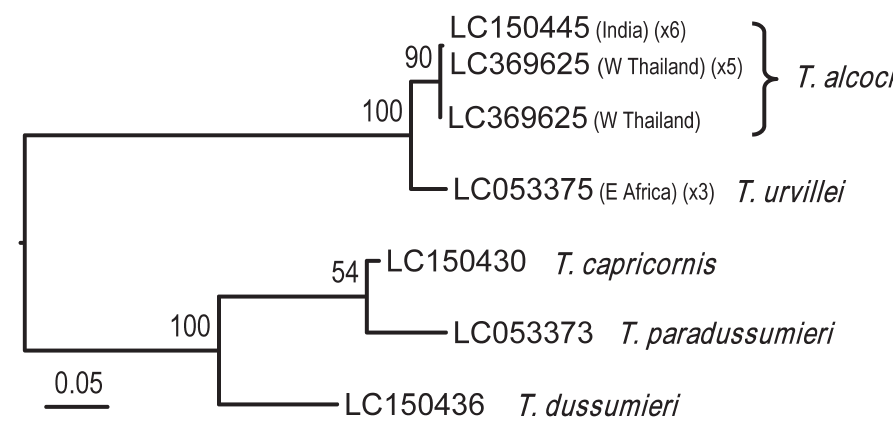
Figure 8. A maximum likelihood (ML) tree for Tubuca urvillei (H. Milne Edwards, 1852) and T. alcocki sp. n. from the Indian Ocean, and outgroups, based on COI gene. Bootstrap proportions are shown at the nodes. For accession numbers, see Table 1 and Materials and